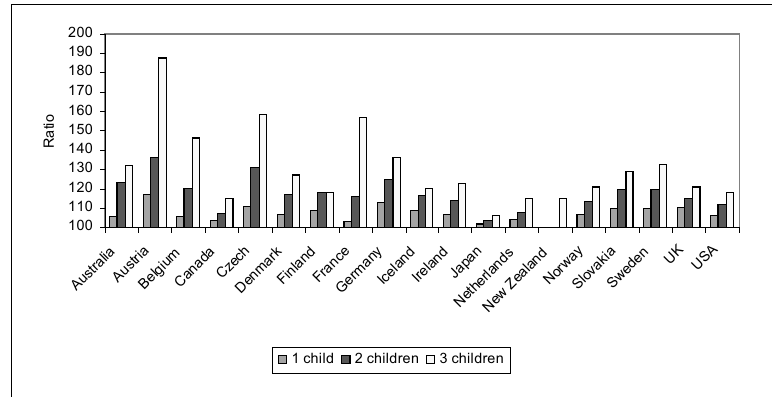
Figure 19 : Child benefit package for a couple by number of children, one earner average earnings. January 2004. Childless couple